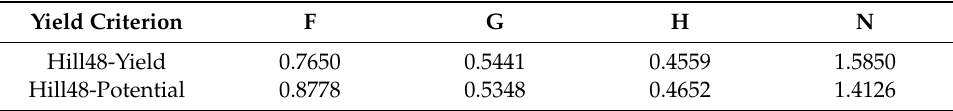
Table 5. Hill’s 48 coe ffi cients for AA 2008-T4